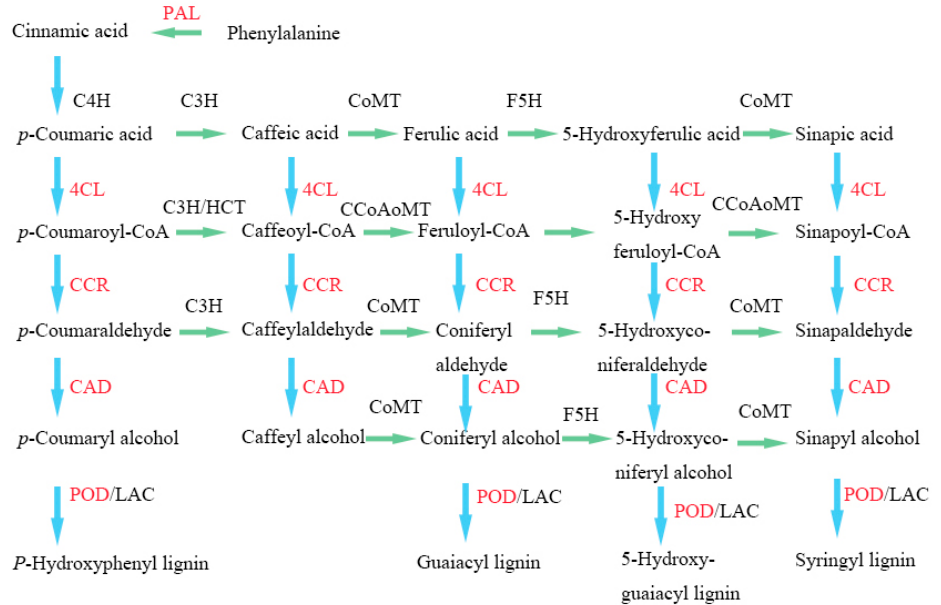
Figure 1. Lignin biosynthetic pathway.